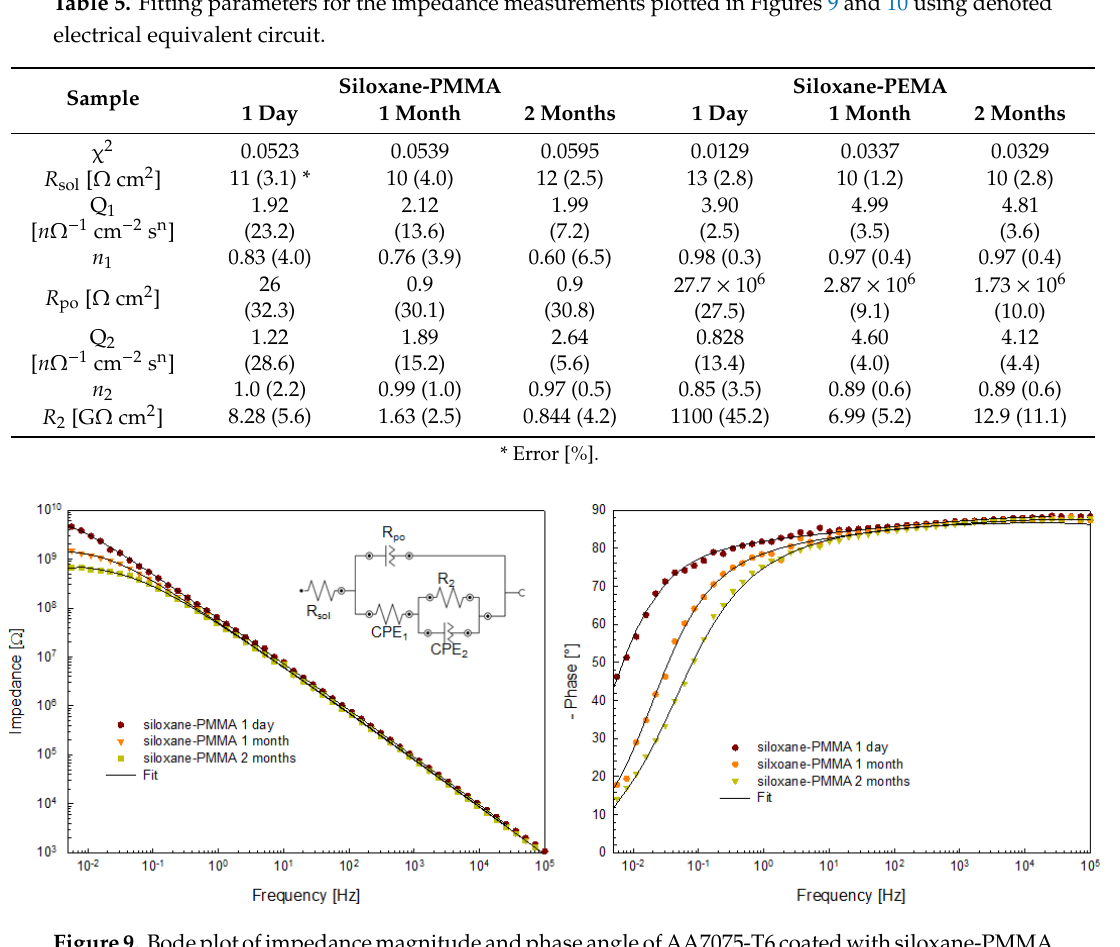
Figure 9. Bode plot of impedance magnitude and phase angle of AA7075-T6 coated with siloxane-PMMA measured after immersion in 0.1 M NaCl for up to 2 months. Symbols correspond to the experimental data and lines to the fitted curves. Electrical equivalent circuit used to fit the experimental data is given in inset; fitted parameters are presented in Table 5.